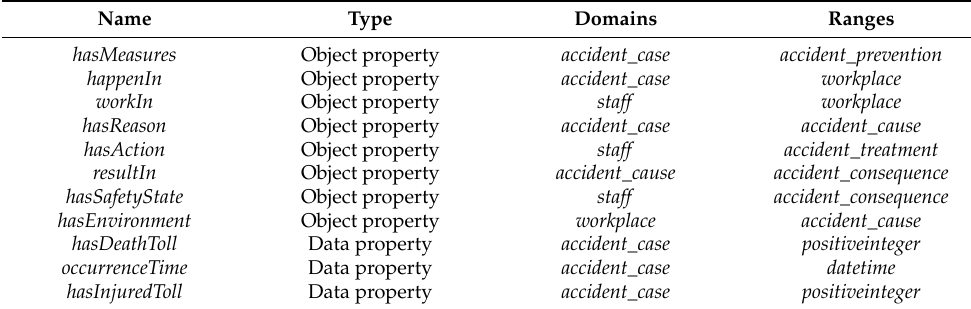
Table 1. Some properties in roof fall accident ontology.